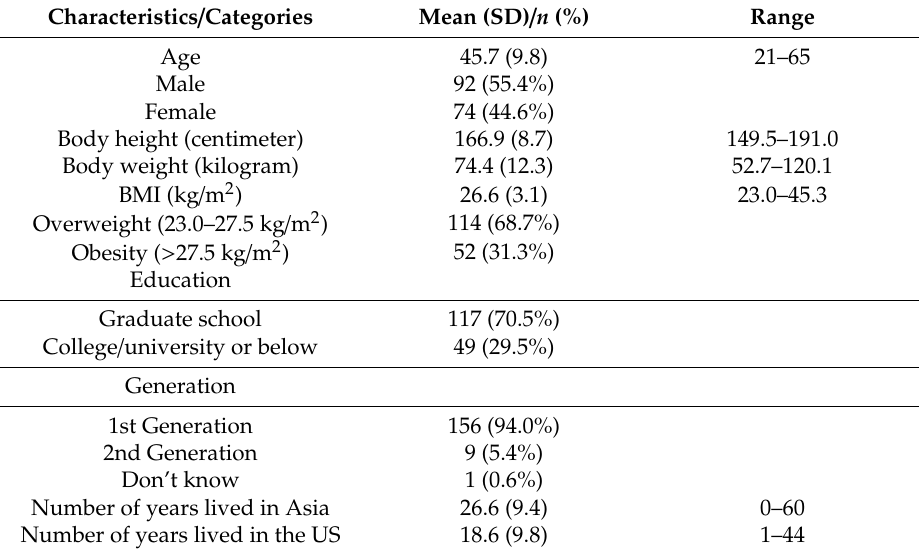
Table 1. Demographic characteristics of participants ( n =